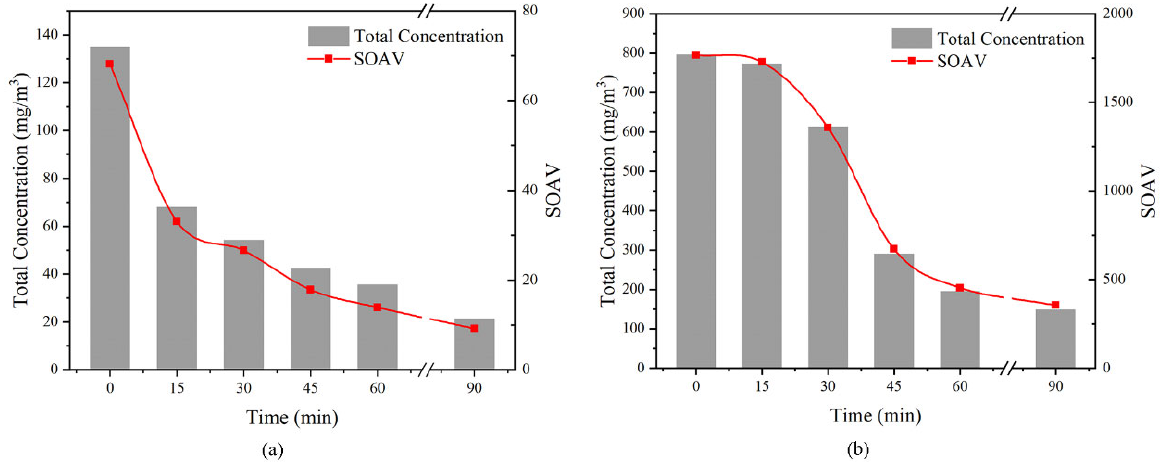
Figure 5. Trends in concentrations and odor potentials with the pre-emission time of white emulsion adhesive ( a ) and silicone adhesive ( b ).